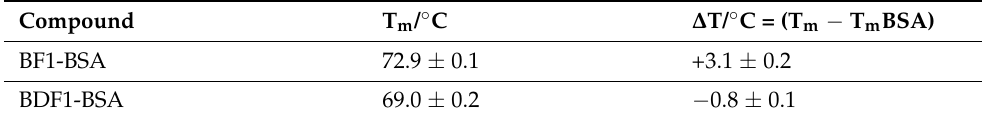
Table 2. Summary table of the melting temperatures (T m ) and their variations ( ∆ T m ) with their respective error bars, with respect to the unliganded protein 1 for the complexes BF1-BSA and BDF1-BSA.